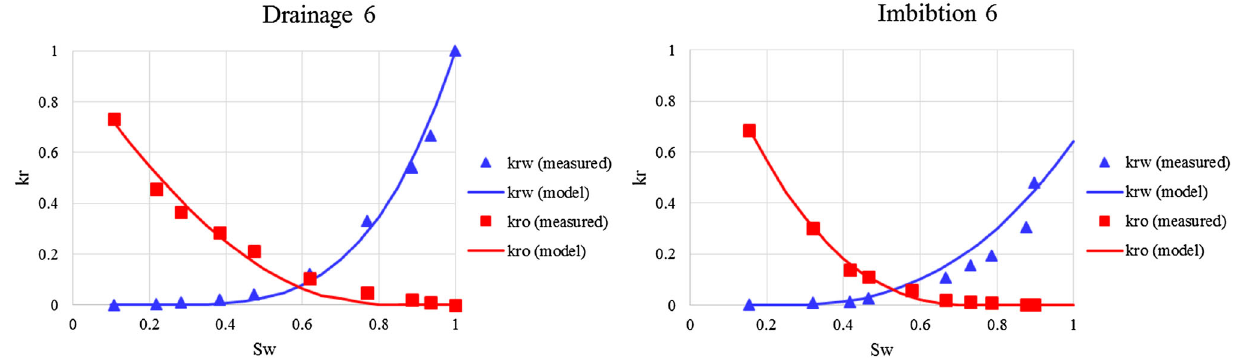
Fig. 17 Drainage and imbibition K r correlation for sample plug #6